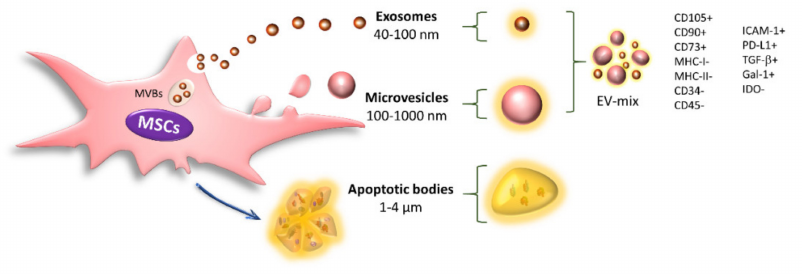
Figure 3. Classification of extracellular vesicles. EVs are classified into exosomes, microvesicles, and apoptotic bodies. Exosomes and MVs are important intercellular communication mechanisms. These structures transport different molecules inside or on the membrane, through which they modify the behavior of their target cells. Some of the main molecules identified in EVs released by resting MSCs are